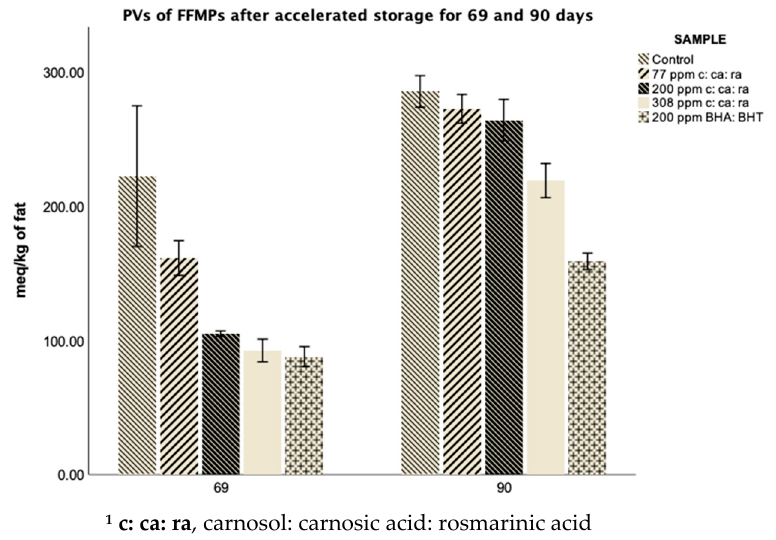
Figure 1. PVs of the FFMPs after accelerated storage (40 °C, RH 23%) for 69 and 90 days, with or without the addition of antioxidants. Values are the mean of three replicates ( n = 3) ± SD 1 .